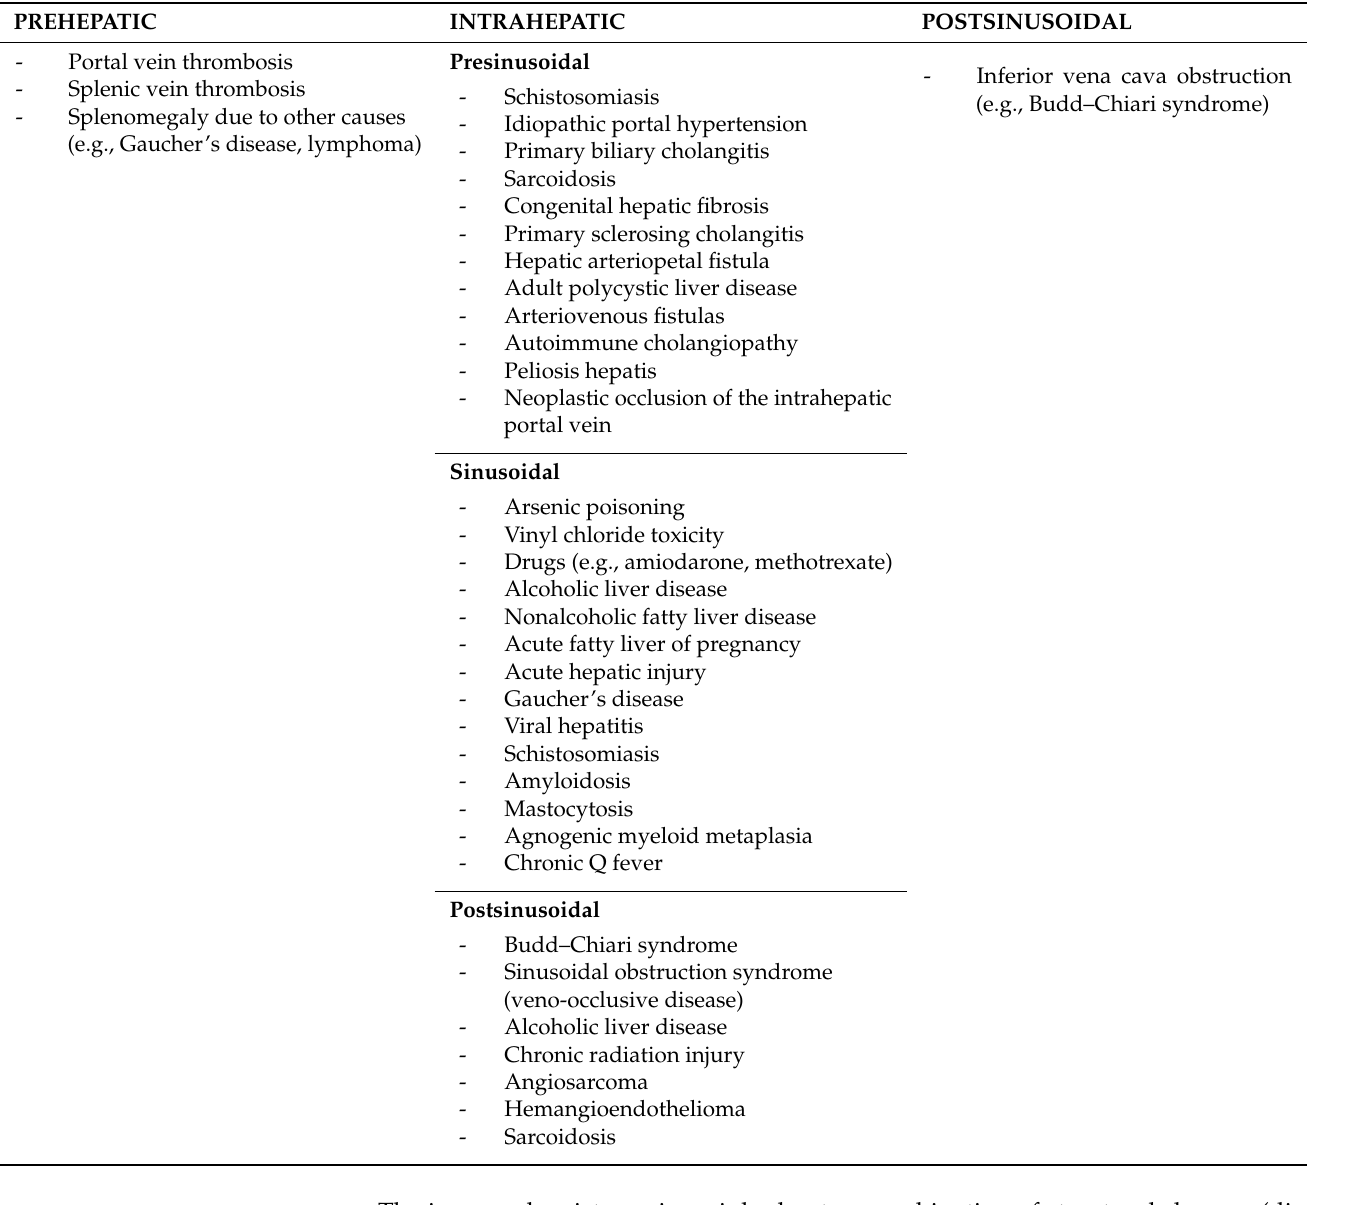
Table 1. Causes of noncirrhotic portal